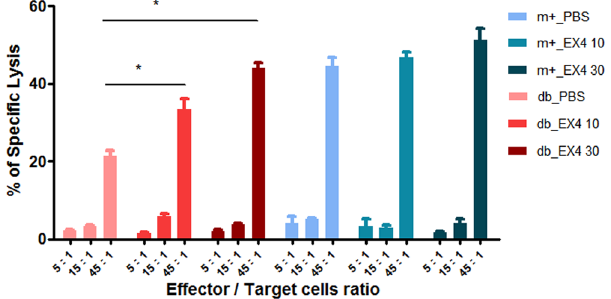
Figure 5. E7-specific CTL response induced by exendin-4. Male db/db and db/m + mice inoculated with 2 × 10 7 CUP-1 cells were treated with 10 nM/kg or 30 nM/kg of exendin-4 intraperitoneally daily for 13 days. After treatment, splenocytes were collected from sacrificed mice, subjected to 5 days of in vitro stimulation with HPV-16 E7 49–57 peptides and used as effector cells. CTL activity was assessed by LDH assay using CUP-1 cells as target cells. Percentage of cytotoxicity (specific lysis) was calculated for cultures with effector:target ratios of 5:1, 15:1 and 45:1. Results are expressed as percentage cytotoxicity ± SEM. * p < 0.05.